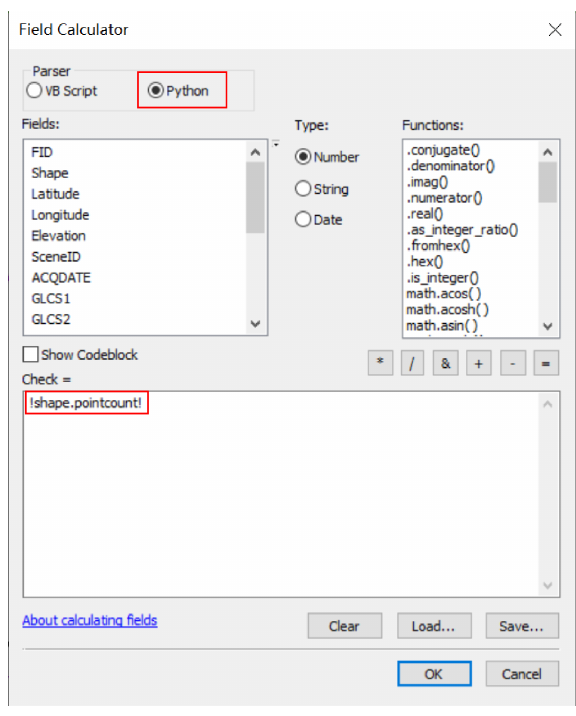
Figure A2. Total node calculation in ArcGIS.